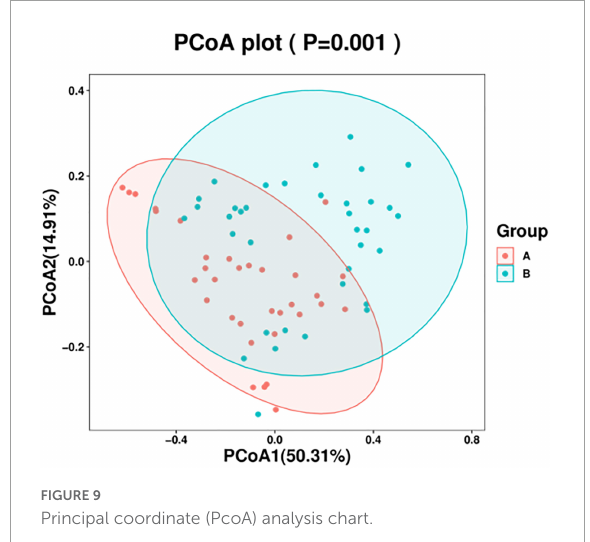
FIGURE9 Principal coordinate (PcoA) analysis chart.